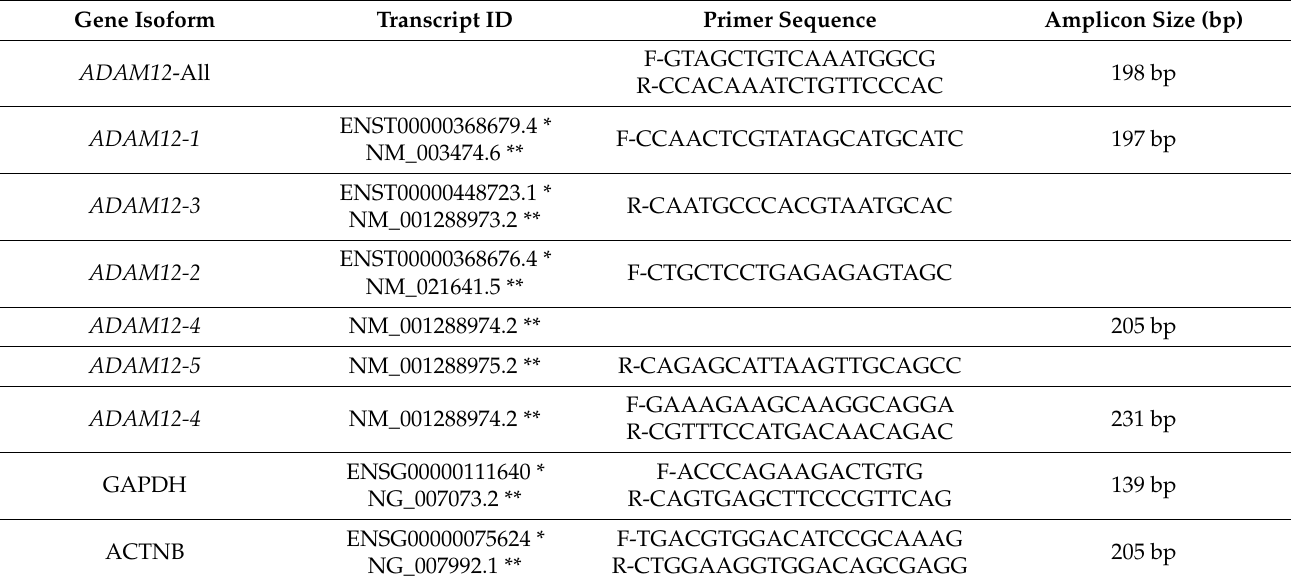
Table 1. Primer pairs used to amplify the alternatively spliced protein coding isoforms of MUC4 and the housekeeping genes.